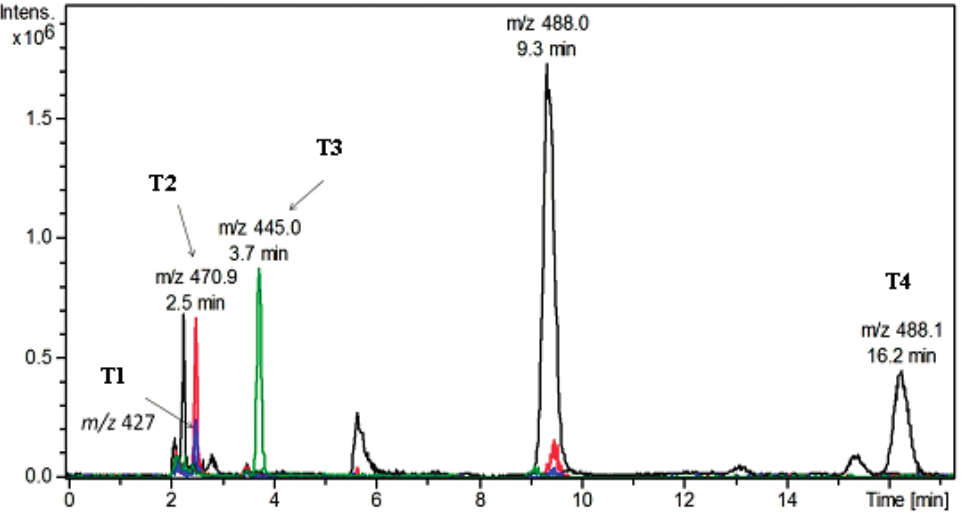
Figure 3. Representative (overlay) of extracted ion chromatograms (EIC) of treponemycin and its metabolites in different culture